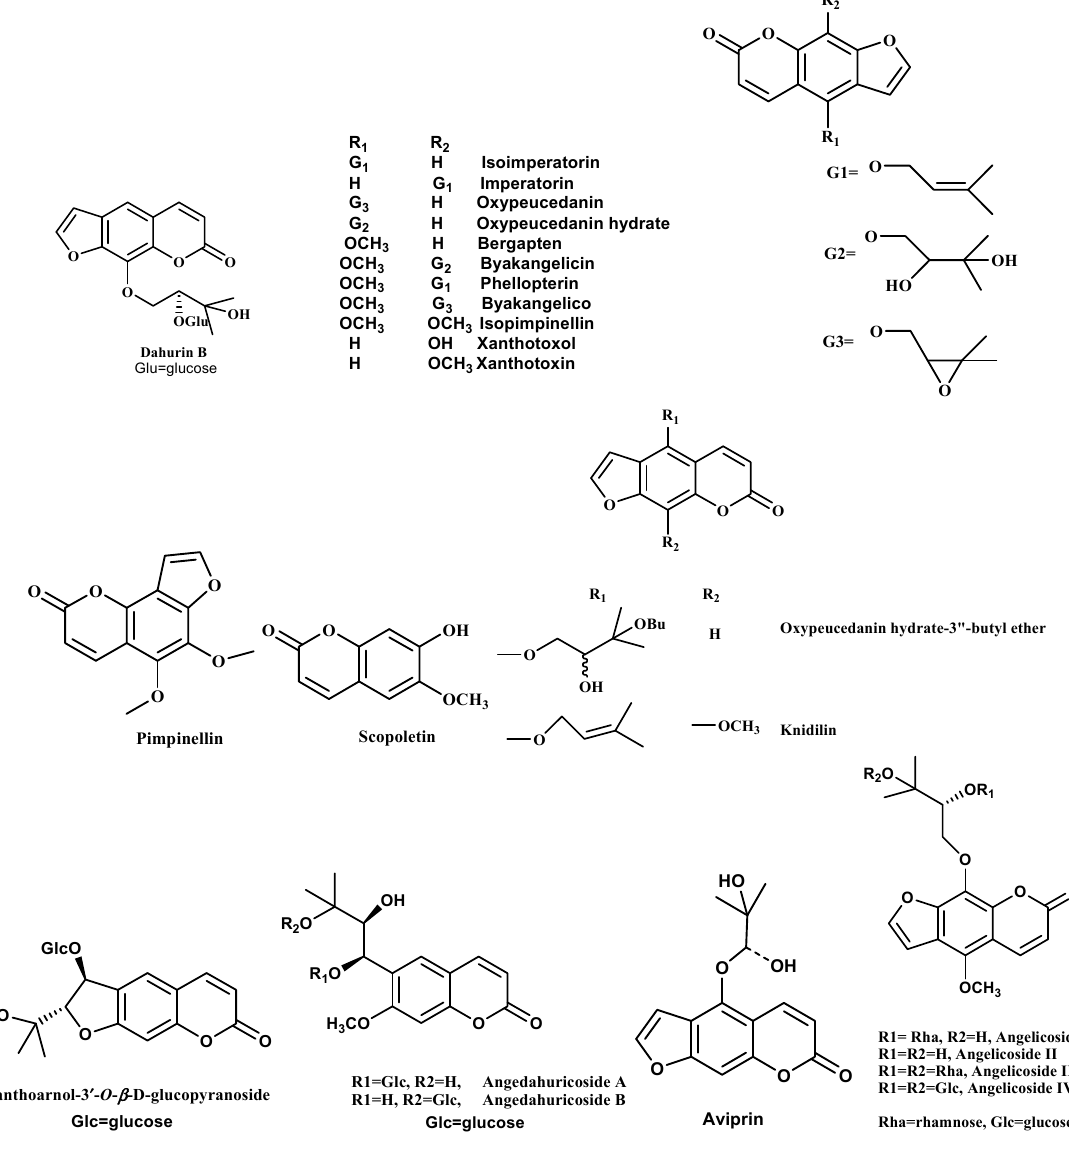
Figure 2. Structures of coumarins and furanocoumarins isolated from genus Angelica . Li and Wu (2017) investigated the chemical constituents of A. dahurica . Fifteen com- pounds have been identified as isoimperatorin (1), imperatorin (2), oxypeucedanin (3), oxypeucedanin hydrate (4), bergapten (5), byakangelicin (6), phellopterin (7), byakangeli- col (8), isopimpinellin (9), xanthotoxol (10), xanthotoxin (11), pimpinellin (12), scopoletin (13) (Figure 2), β -sitosterol (14), and daucosterol (15) [71,72]. Kim et al. (2002) found that the A. dahurica roots’ methanol extract fractionation led to the isolation of three furanocoumarins, namely isoimperatorin, imperatorin, and oxy- peucedanin (Figure 2). The isolated compounds inhibited AChE activity in a dose-de- pendent manner (IC 50 63.7 to 89.1 µM) [73]. In another study, five furanocoumarins (isoimperatorin, oxypeucedanin hydrate-3”-butyl ether, imperatorin, knidilin, and oxy- peucedanin hydrate) (Figure 2) were isolated from the root of A. dahurica by repeated sil- ica-gel column chromatography [74]. Yang et al. (2020) utilized a quantitative 1 HNMR method ( 1 H-qNMR) for the deter- mination of the imperatorin, akangelicin, and oxypeucedanin content in A. dahurica, which are part of traditional Chinese medicine (TCM). The extraction was performed us- ing an ultrasonication-assisted extraction method. The quantitative proton NMR